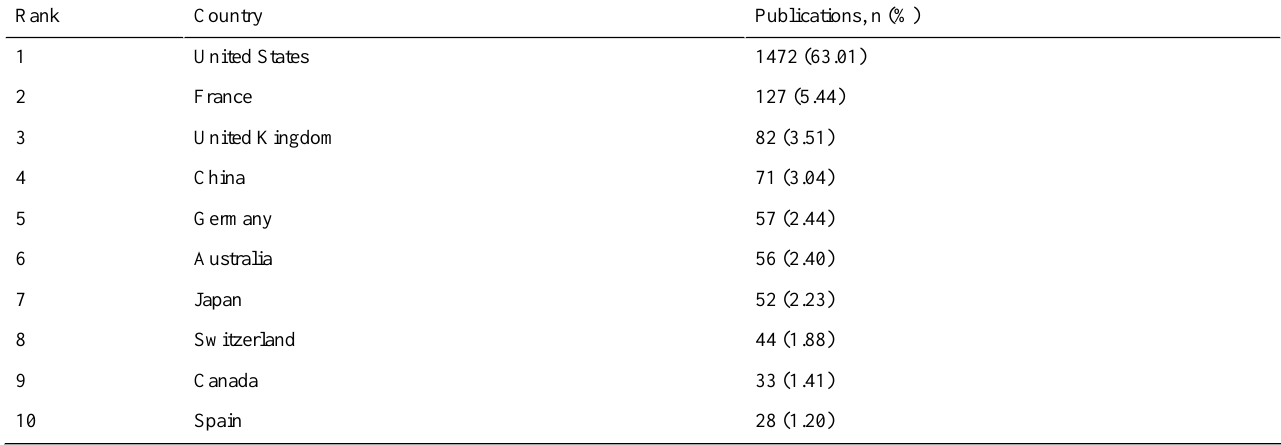
Table 4. Ranking of the first author’s countries (top 10,